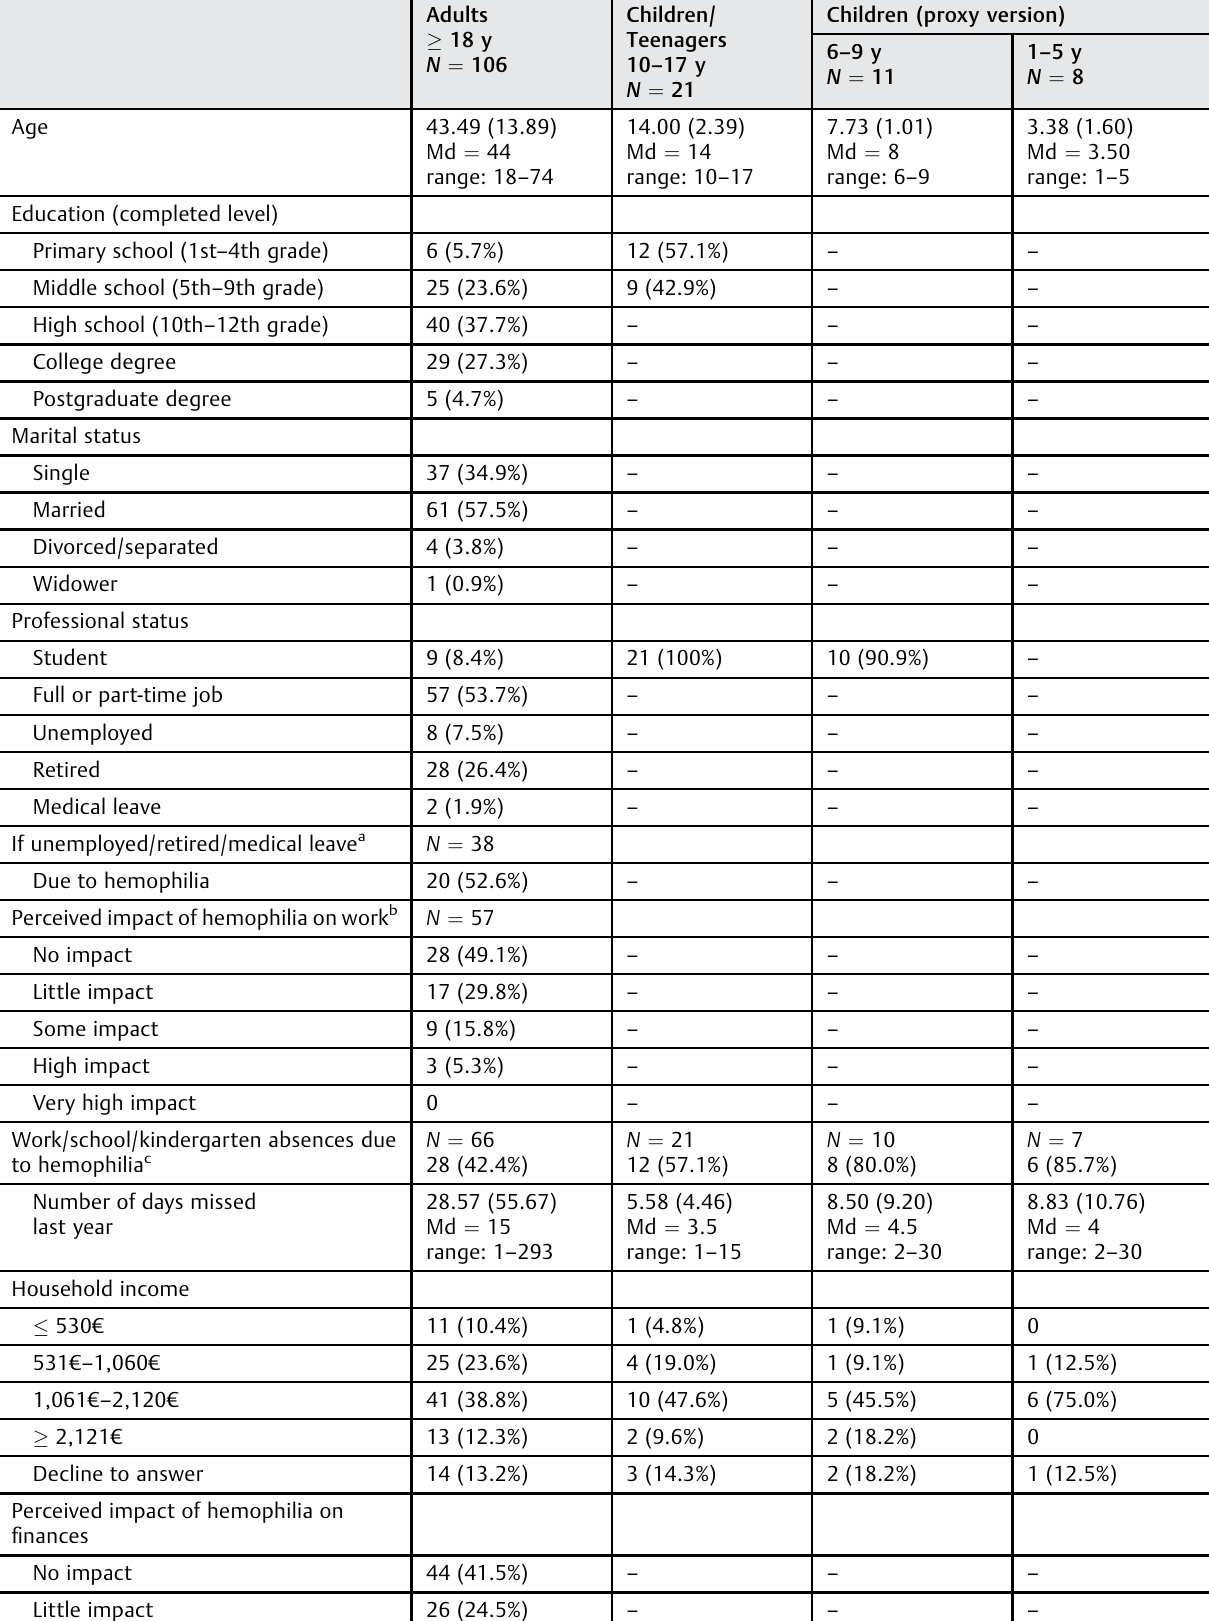
Table 2 Sociodemographic information of survey